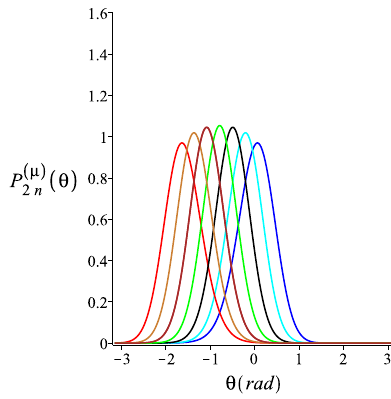
+ π i , where i = 0,1,2,3,4,5,6, 2 6 = 12.5, n = 1, and K = , φ µ = 0, l p B L 4